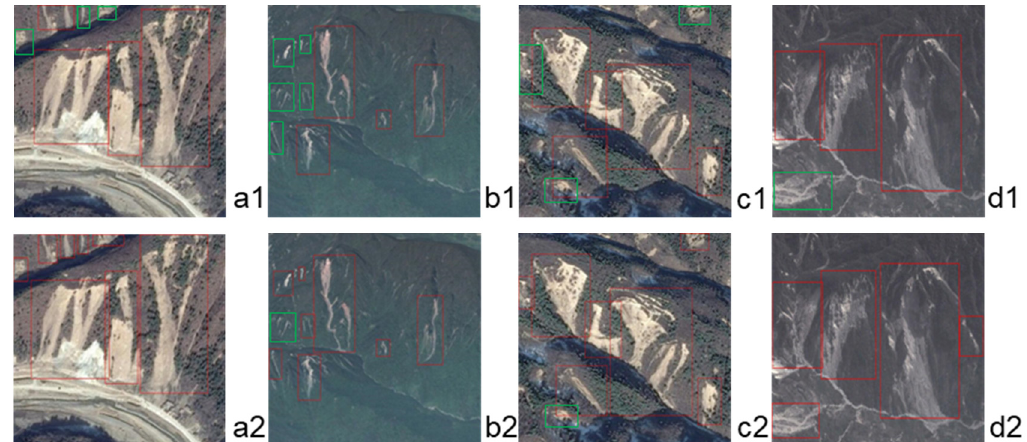
Figure 12. Comparison of detection results of YOLOX(M) and YOLOX-Pro(M) models. The red target boxes indicate the landslides automatically detected by the model, and the green target boxes are the manually labeled missed landslides. ( a1 – c1 ): the detection effect of small landslides is poor, and there are many missed detections; d1: the debris flow in the lower left corner of the image was missed; ( a2 – d2 ): better detection performance, least missed detection.